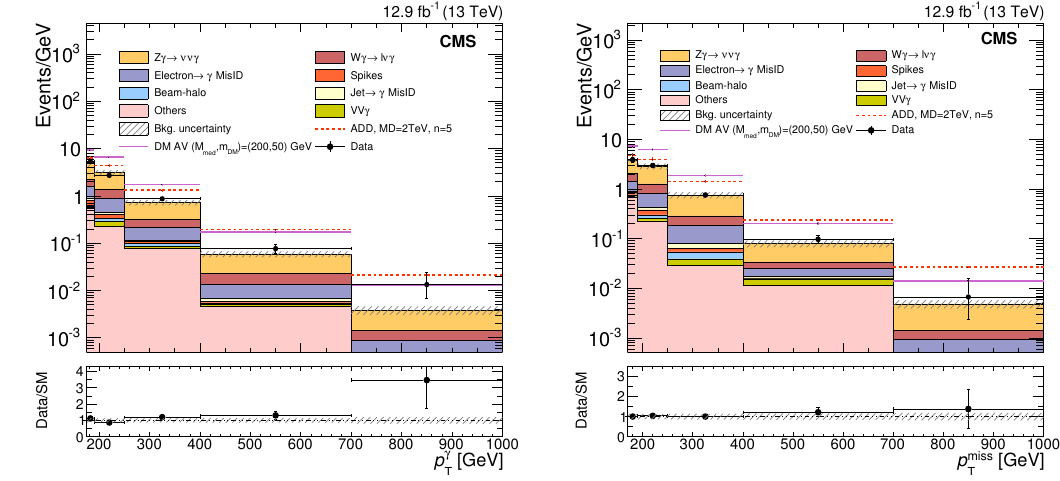
Figure 2 . The p (cid:13) (left) and p miss (right) distributions for the candidate sample, compared with esti- T T mated contributions from SM backgrounds. In the legends, \others" includes the contribution from (cid:13) +jets, W ! ‘(cid:23) , Z( ! ‘‘ )+ (cid:13) , and tt (cid:13) backgrounds. The background uncertainties include statisti- cal and systematic components. The last bin includes the over(cid:13)ow. The lower panel shows the ratio of data and SM background predictions, where the hatched band shows the systematic